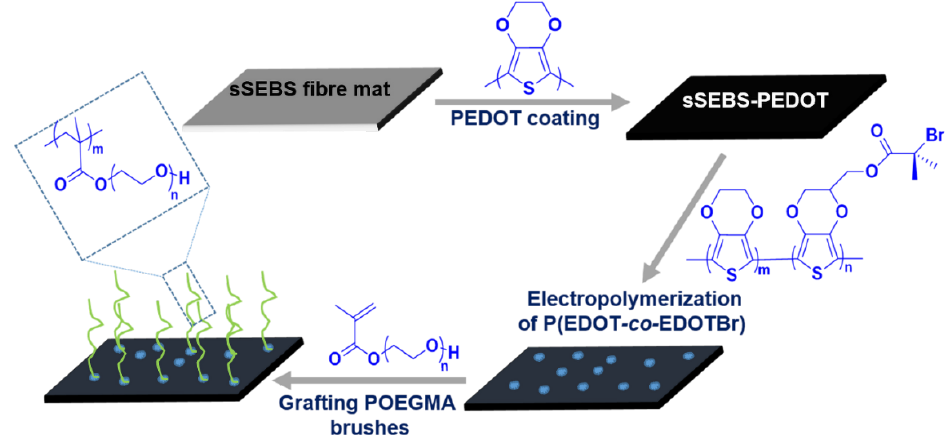
Figure 1. Schematic representation of fabrication of sSEBS-PEDOT/P(EDOT-co-EDOTBr) fibre mat with grafted POEGMA brushes.